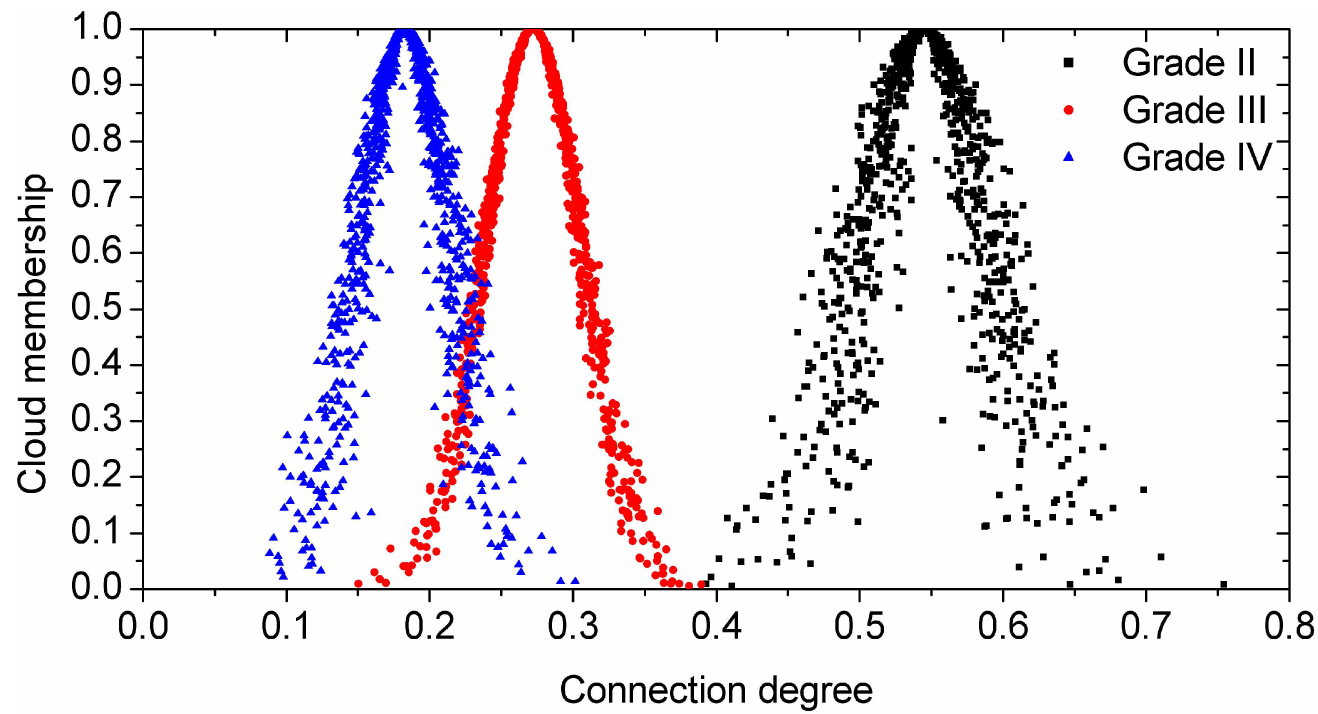
Fig 4. Normal clouds of CCD for Yanjia